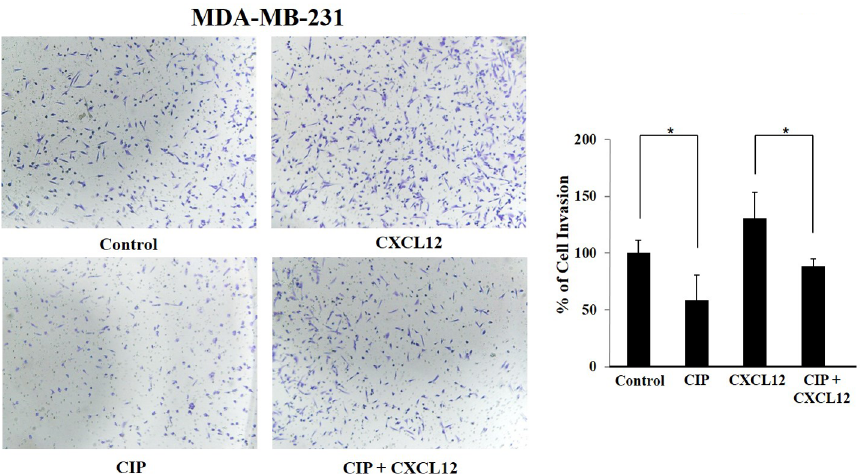
crystal violet solution and invaded cells were counted in five randomly selected areas. CIP significantly suppressed the cell invasion both in the presence and absence of CXCL12 suggesting that CIP interferes with invasive potential of breast cancer cells.